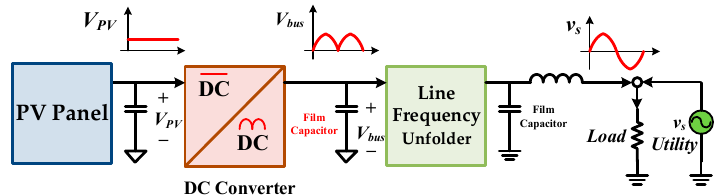
Figure 3. PV grid-connection systems with the pseudo-dc-link structure.